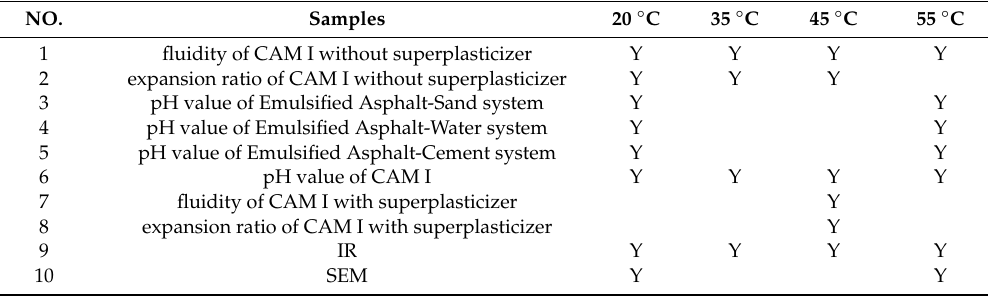
Table 4. Summary of test program.